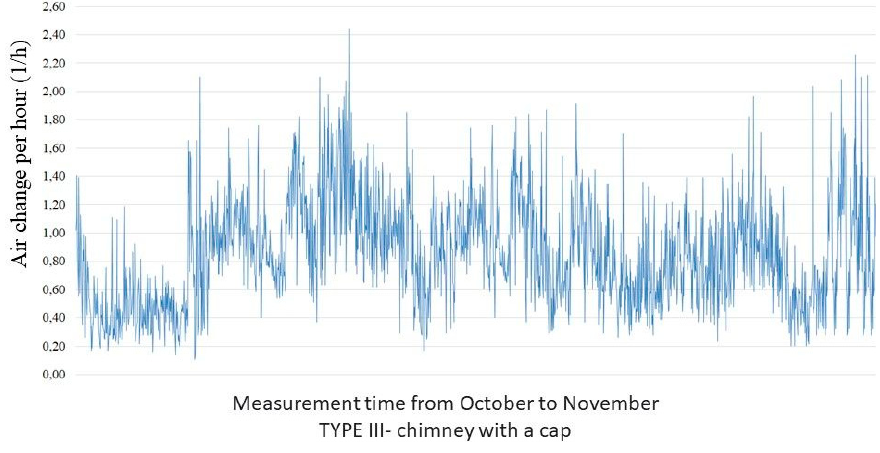
Figure 16. Gravity ventilation efficiency—chimney with a cap TYPE III.